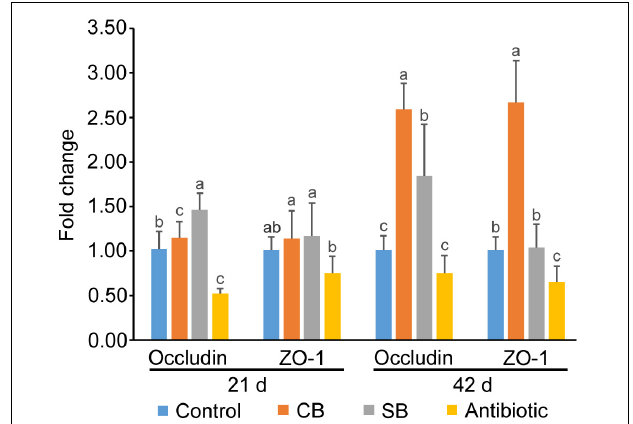
FIGURE 2 | Gene expression of tight junction proteins in broiler jejunum. Significant differences are shown by bars labeled with various